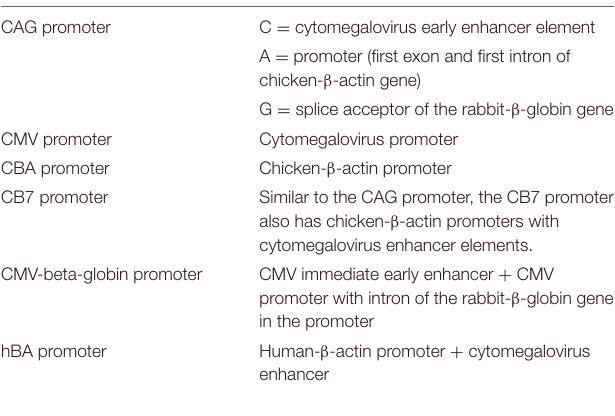
TABLE 4 | Different promoters used in viral gene therapy.